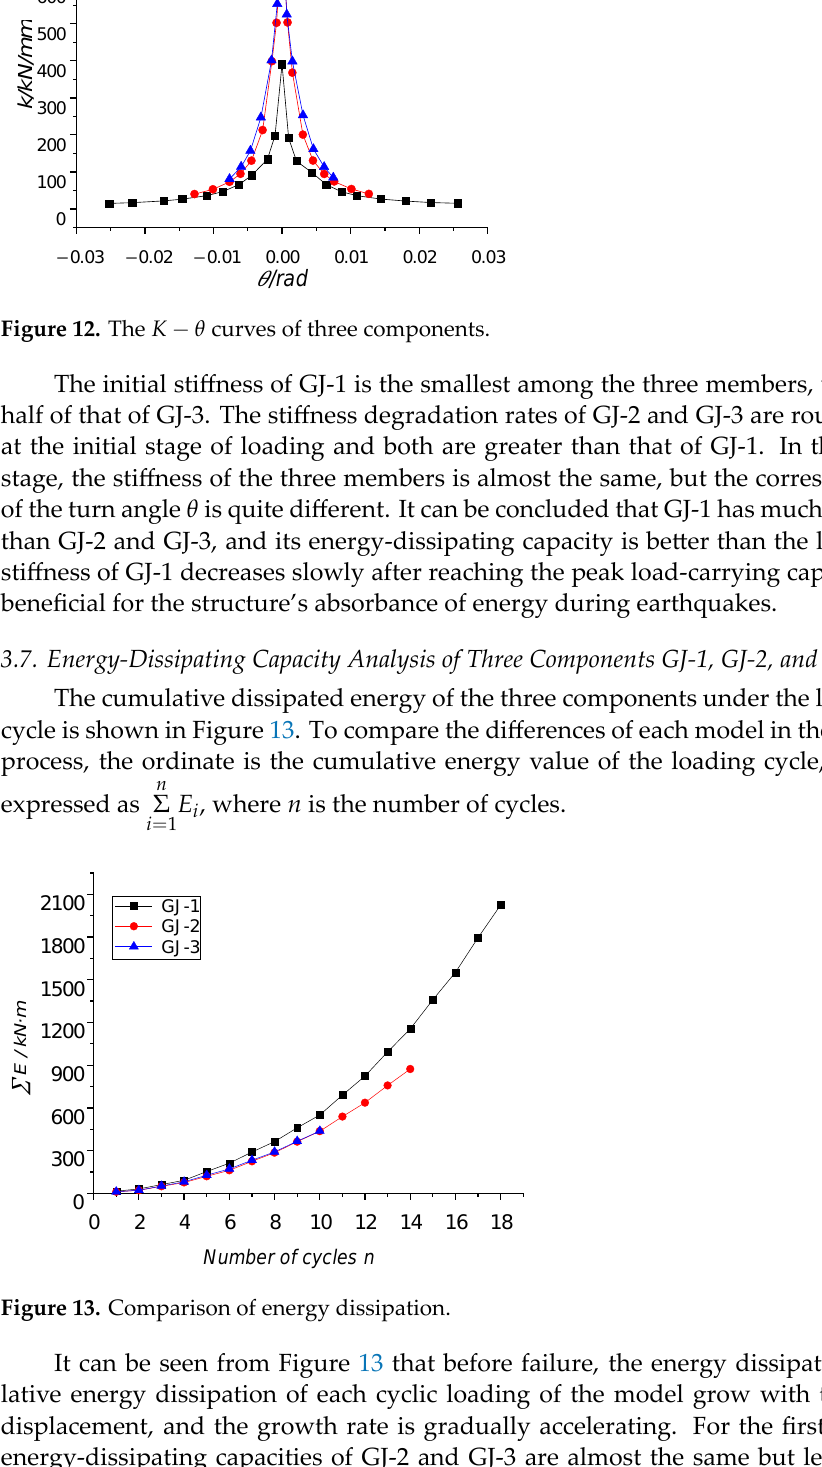
Figure 13. Comparison of energy dissipation.